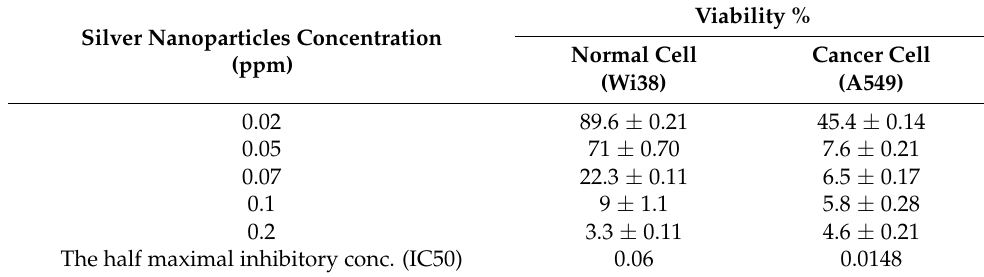
Table 3. The percentage of survival lung cells treated by different concentrations of AgNPs produced by Streptomyces aizuneusis cell